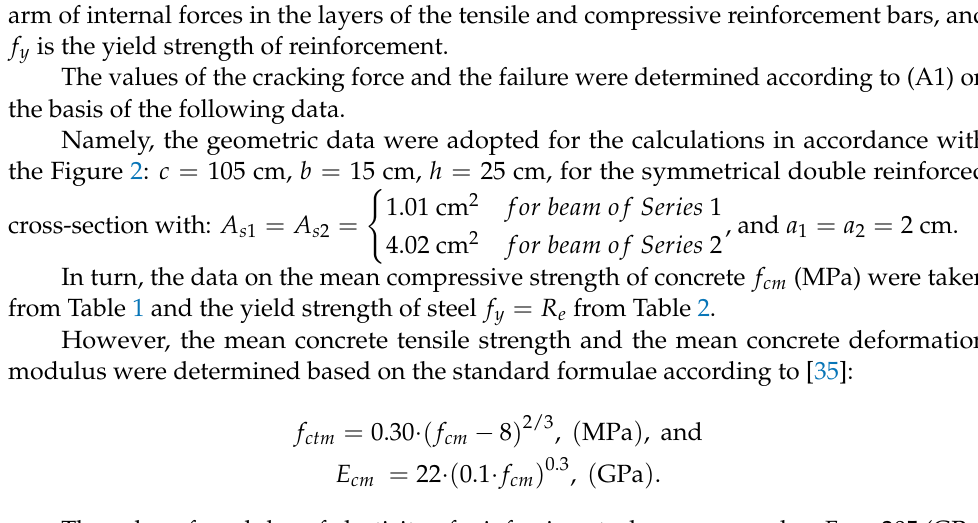
Namely, the geometric data were adopted for the calculations in accordance with the Figure 2: c = 105 cm, b = 15 cm, h = 25 cm, for the symmetrical double reinforced (cid:40) 1.01 cm 2 f or beam o f Series 1 cross-section with: A s 1 = A s 2 = 2, and a 1 = a 2 = 2 cm. 4.02 cm 2 f or beam o f Series In turn, the data on the mean compressive strength of concrete f cm (MPa) were taken from Table 1 and the yield strength of steel f y = R e from Table